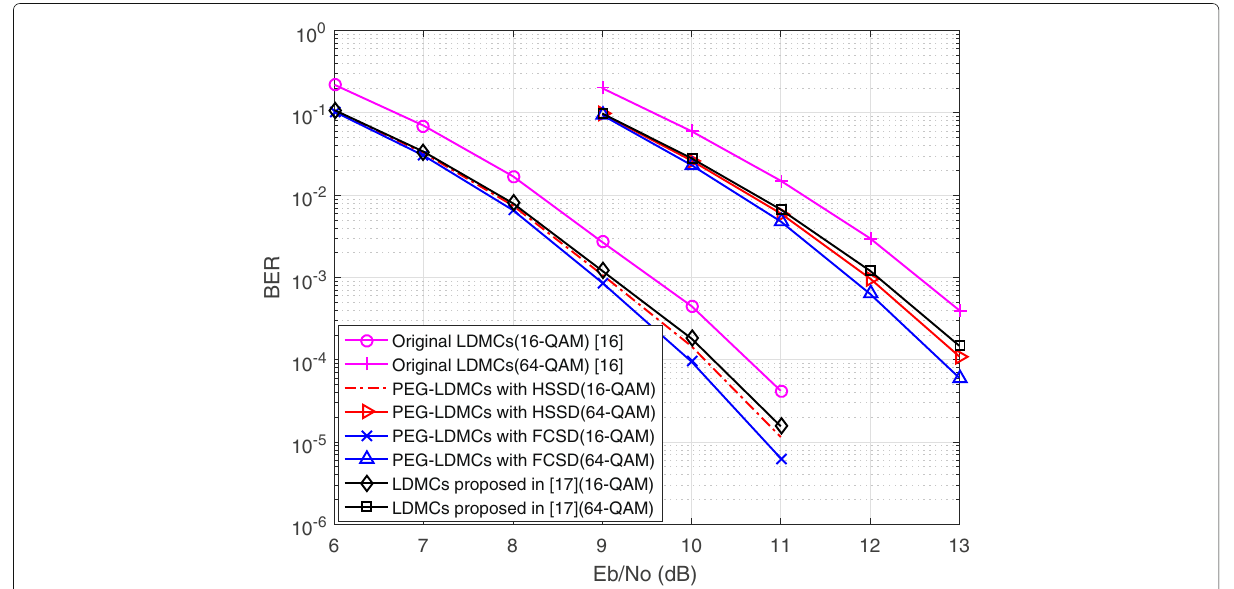
Fig. 2 BER performance comparison of PEG-LDMCs, LDMCs proposed in [17] and original LDMCs in [16] with 16-QAM and 64-QAM